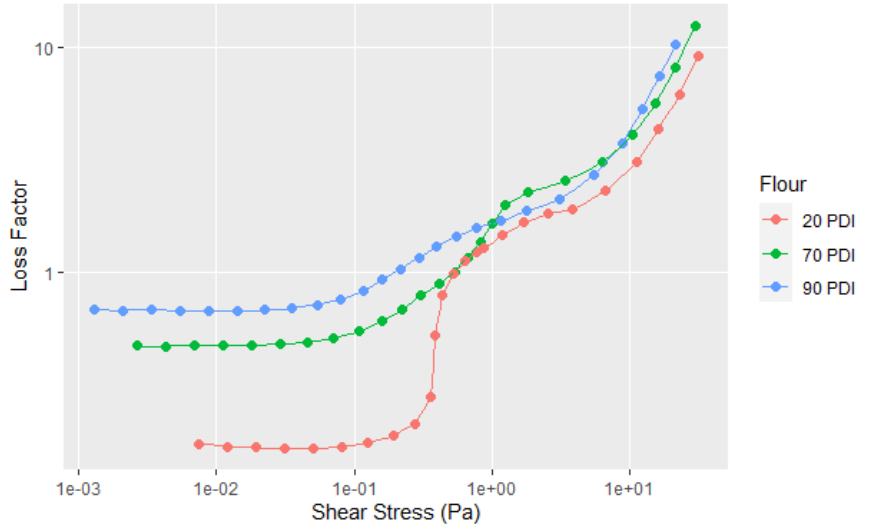
Figure 9. Loss factor data for the samples shown in Figure 8. Single test shown (not average). All replicates shown in A8.